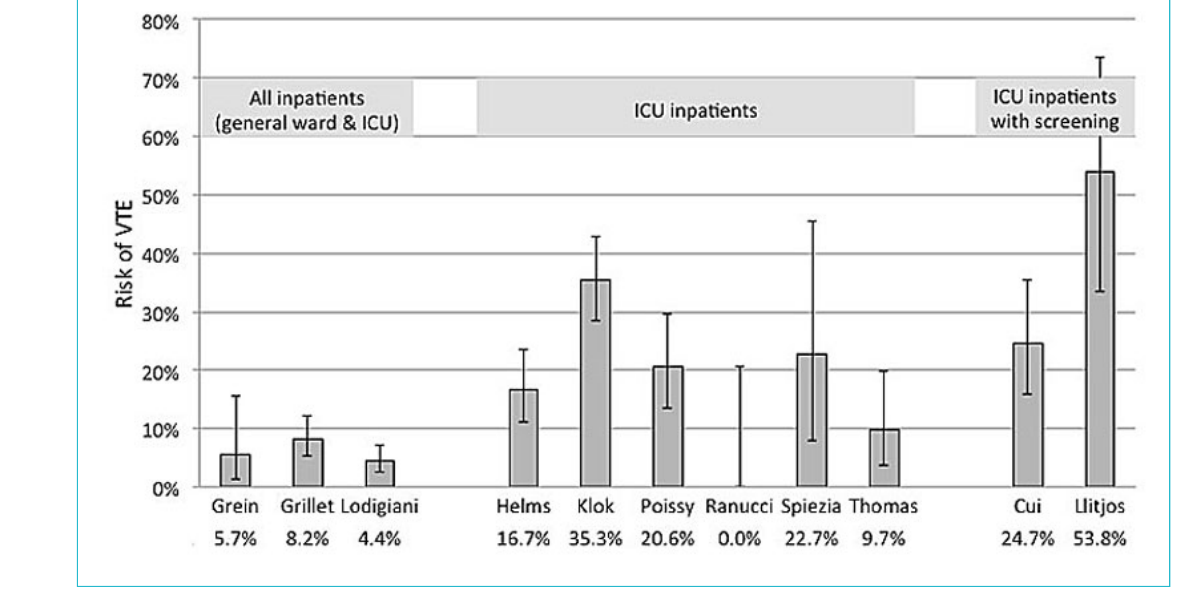
Figure 2: Risks of venous thromboembolism (VTE) in individual studies, obtained from simple proportions (n VTE / n at risk). Error bars repre- sent 95% confidence intervals. ICU = intensive care